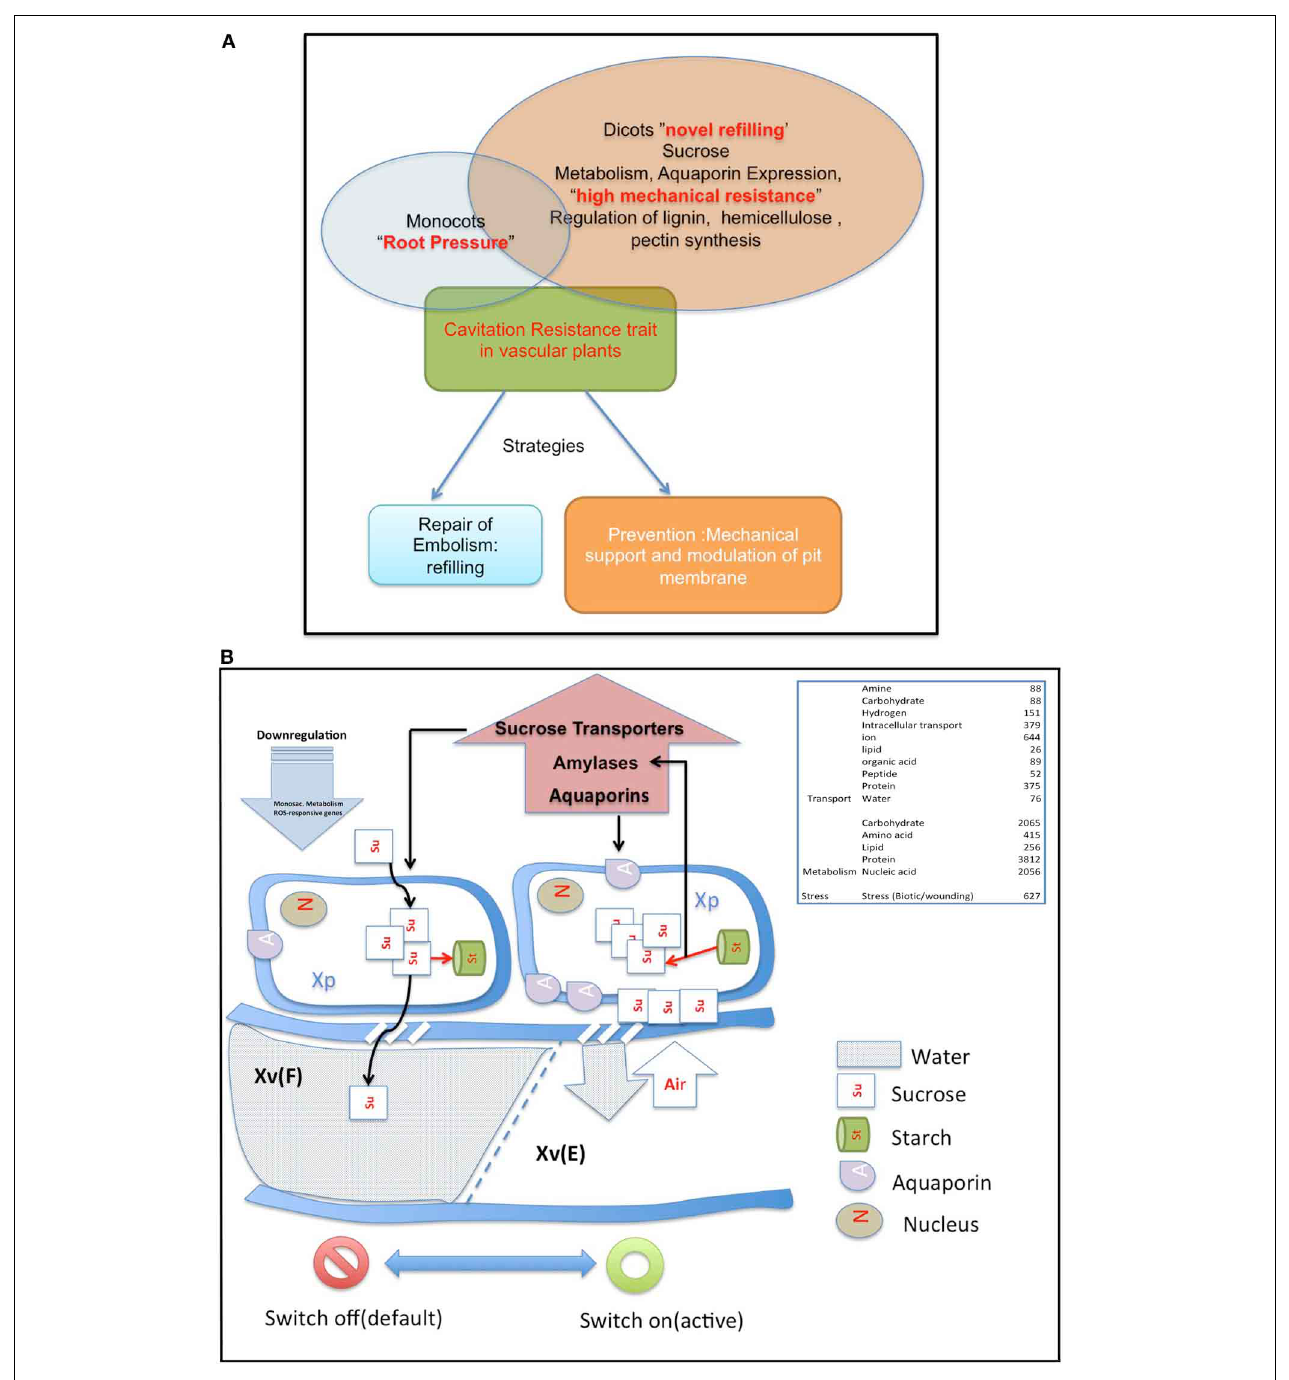
FIGURE 2 | (A) The strategies of vascular plant in a battle against embolism. Monocots often employ root pressure, while dicots employ novel refilling mechanism, and mechanical resistance to resist cavitation. There is no clear demarcation between the strategies employed by the two groups, and the strategies may overlap. (B) The sugar sensing model of embolism refilling process, modified from Secchi et al. (2011). For detail explanations of the model, refer text and Secchi et al. (2011). Briefly, when vessels are filled and functional, a default “switch off” mode is active. Sucrose is continuously transported from accompanying xylem parenchyma cells into the vessels.